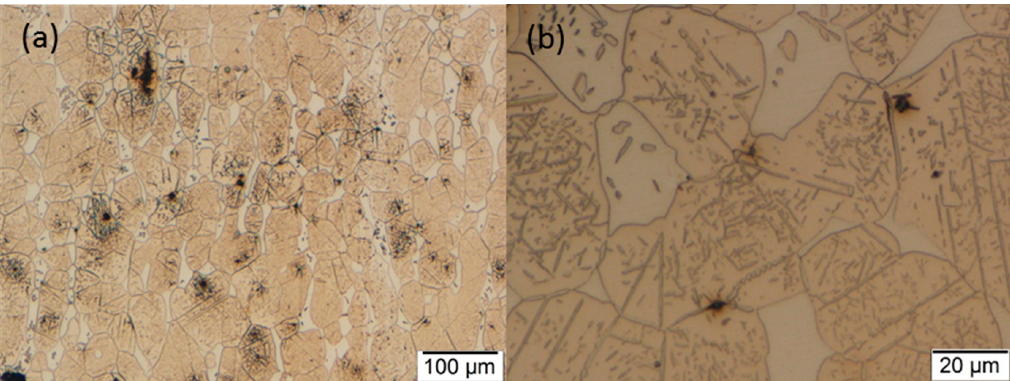
Figure 10. Optical microscopy of the sample that was isothermally annealed at 850 °C, etched with 10% nital, ( a ) ferrite–– white with visible carbide precipitates, and austenite––brown with visible precipitation, ( b ) magnified detail, there is a strong precipitation in austenite, where the precipitates seem to have formed along the twin boundaries, the ferrite grains contain a few coarse carbides.